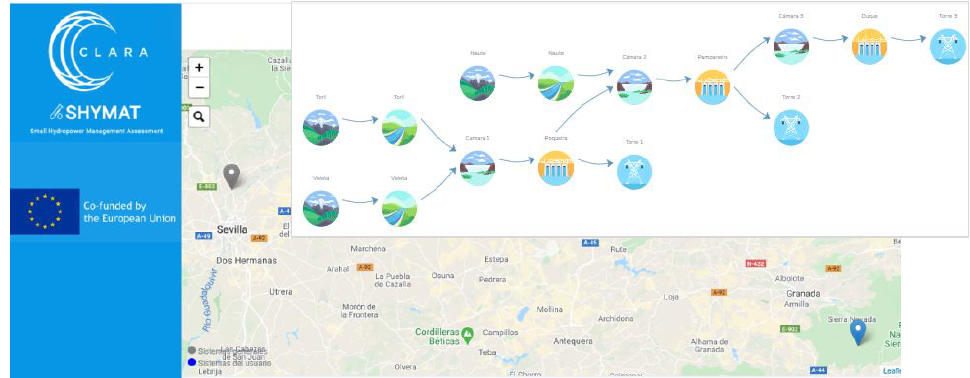
Figure 4. Example of the visualization of the SHYMAT web-user interface. A geolocation panelfor hydropower system selection and the topology panel of the hydropower system selected (appearing on the screen once a particular system is selected by the user), which shows the different elements of the system and the relations among them.